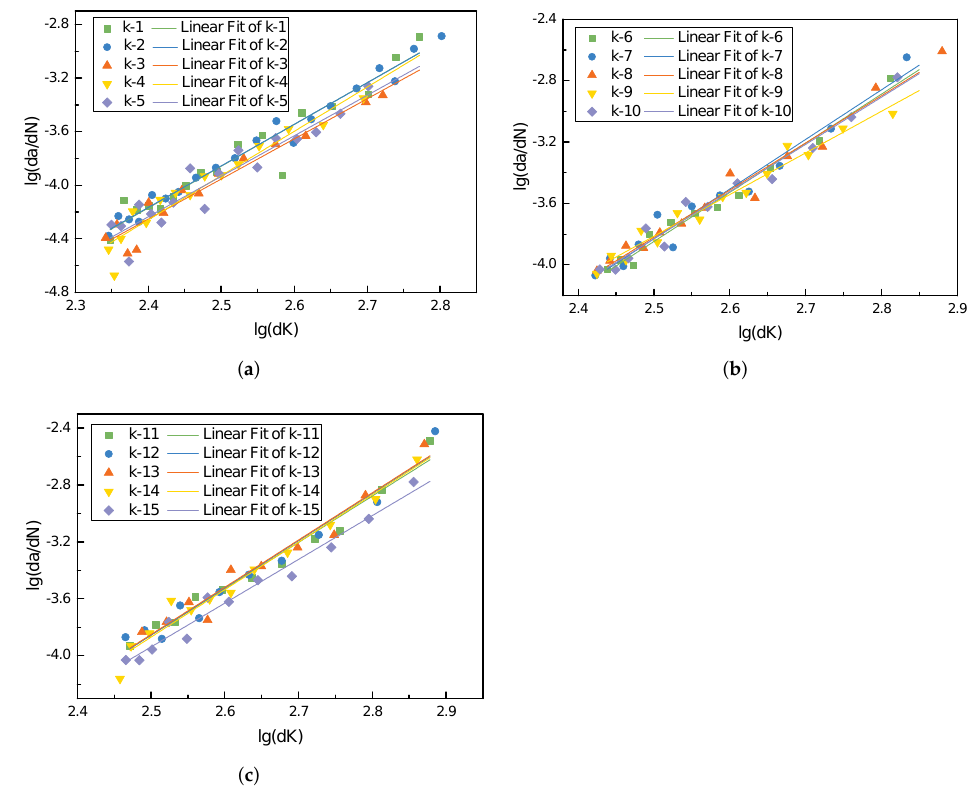
Figure 11. ( a ) log( da / dN ) and log( ∆ K ) linear regression analysis of 15.20 kN. ( b ) log( da / dN ) and log( ∆ K ) linear regression analysis of 18.24 kN. ( c ) log( da / dN ) and log( ∆ K ) linear regression analysis of 19.76 kN. Through linear regression analysis, the crack propagation parameters of all test pieces are obtained, as shown in Figure